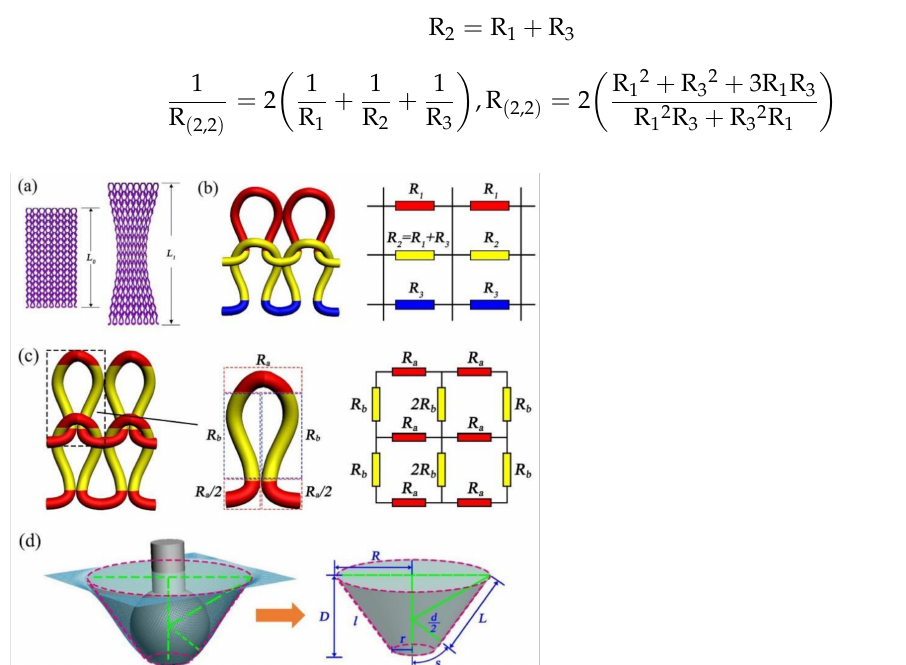
Figure 3. ( a ) macro structure equivalent resistance model; ( b ) micro structure equivalent resistance model; ( c ) topological structure equivalent resistance model; ( d ) three-dimensional surface equivalent resistance